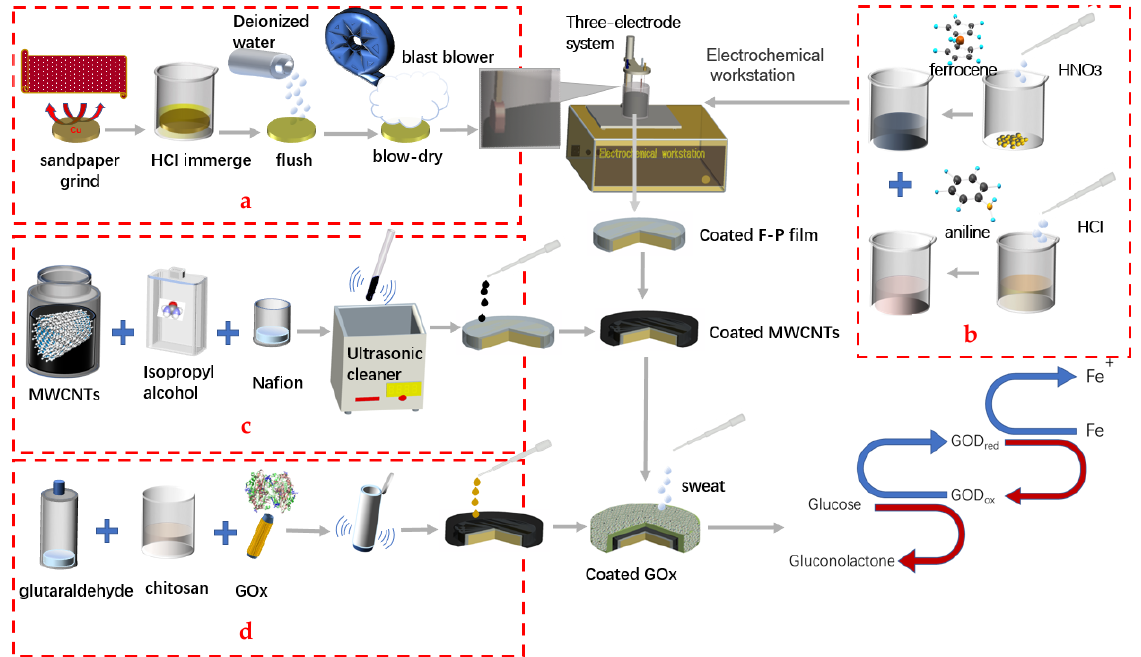
Figure 1. Characterization and fabrication process of paper-based enzyme biosensors coated with F-P film, MWCNTs and GOx. ( a ) step 1: treatment of Cu sheet. ( b ) step 2: preparation of electrolytic solution. ( c ) step 3: dispersion of MWCNTs. ( d ) step 4: preparation of enzyme solution.